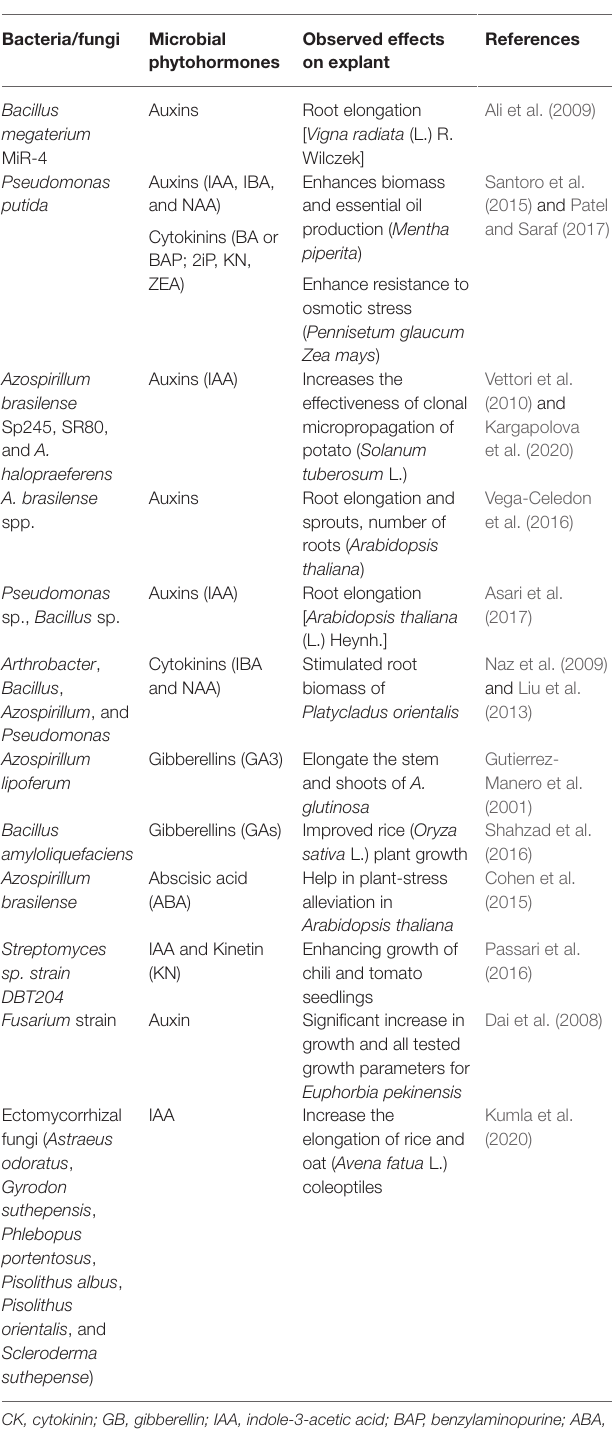
TABLE 2 | Growth regulators produced by microorganisms, and their effect on plant development and morphology.